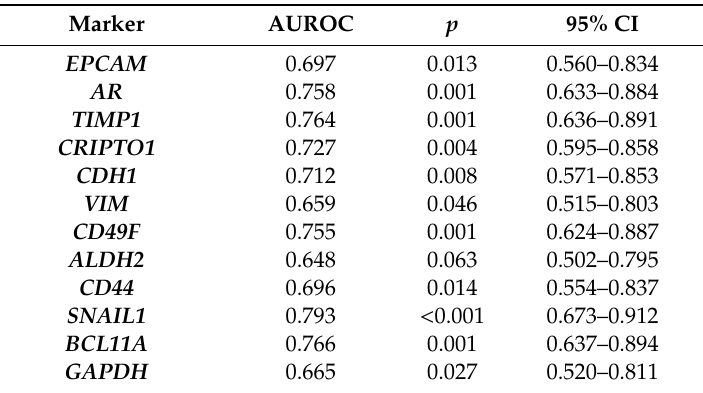
Figure 2. Gene expression profile of CTCs from patients with TNBC. Di ff erential expression levels of genes involved in ( A ) epithelial ( CDH1 , EPCAM ); ( B ) mesenchymal ( VIM , SNAIL1 , TIMP1 , CRIPTO1 , ZEB1 , ZEB2 , LOXL2 ); ( C ) stem cell features ( CD49F , ALDH2 , CD44 , BCL11A , ALDH1 and CD133 ) and ( D ) hormone regulation and this tumor aggressiveness (AR , ANXA2 ) in CTCs from TNBC patients compared to the background signal associated with the unspecific immunoisolation found in healthy controls. Gray symbols represent the gene expression levels in the group of healthy controls ( n = 30), while black symbols are those corresponding to TNBC patients ( n = 32). p values were calculated using two-sided Mann–Whitney U-test. FDR was employed to adjust these p values. Table 3. Diagnostic value of CTC